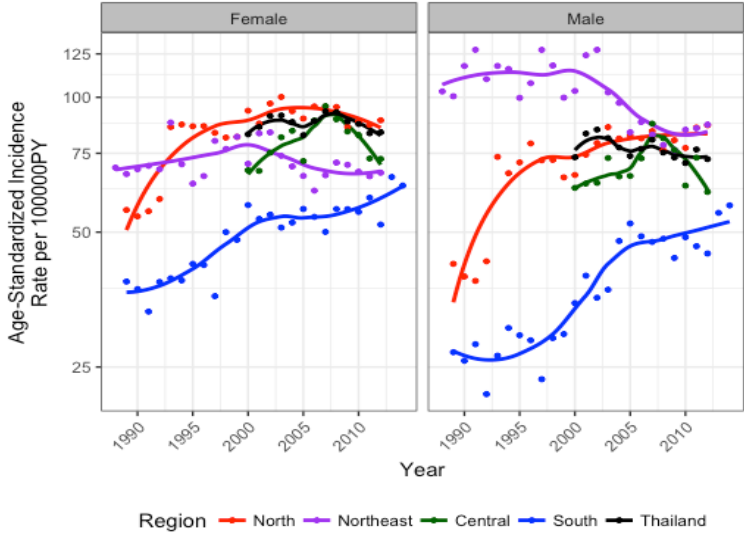
Figure 4. National and subnational estimates for incidence of the top five cancers combined for females and males.